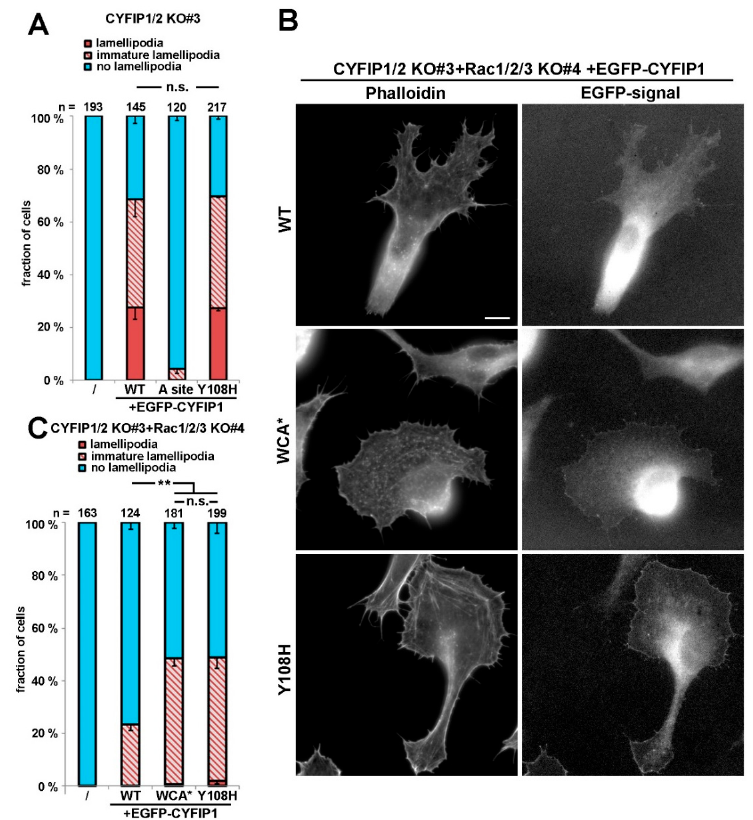
Figure 3. Y108H mutation in CYFIP can augment lamellipodia formation given that the Rac-binding A site is functional. ( A ) Quantification of lamellipodia formation in B16-F1 CYFIP1 / 2 KO cells (clone #3) transfected with indicated EGFP-tagged CYFIP1 constructs, as described for Figure 1A. ( B ) Representative cell images of CYFIP1 / 2 + Rac1 / 2 / 3 KO cells (clone #3 / 4) expressing respective constructs, as indicated. Panels in left column show stainings of the actin cytoskeleton with phalloidin, and right column images show fluorescence of the same cells derived from respective, EGFP-tagged constructs. Scale bar, 10 µ m. ( C ) Quantification of lamellipodia formation in B16-F1 CYFIP1 / 2 + Rac1 / 2 / 3 KO cells (clone #3 / 4), transfected with indicated, EGFP-tagged CYFIP1 constructs, performed in analogy to Figure 1A. Statistical significance was assessed by two-sample, two-sided t-test. n.s.: not statistically significant; ** p <